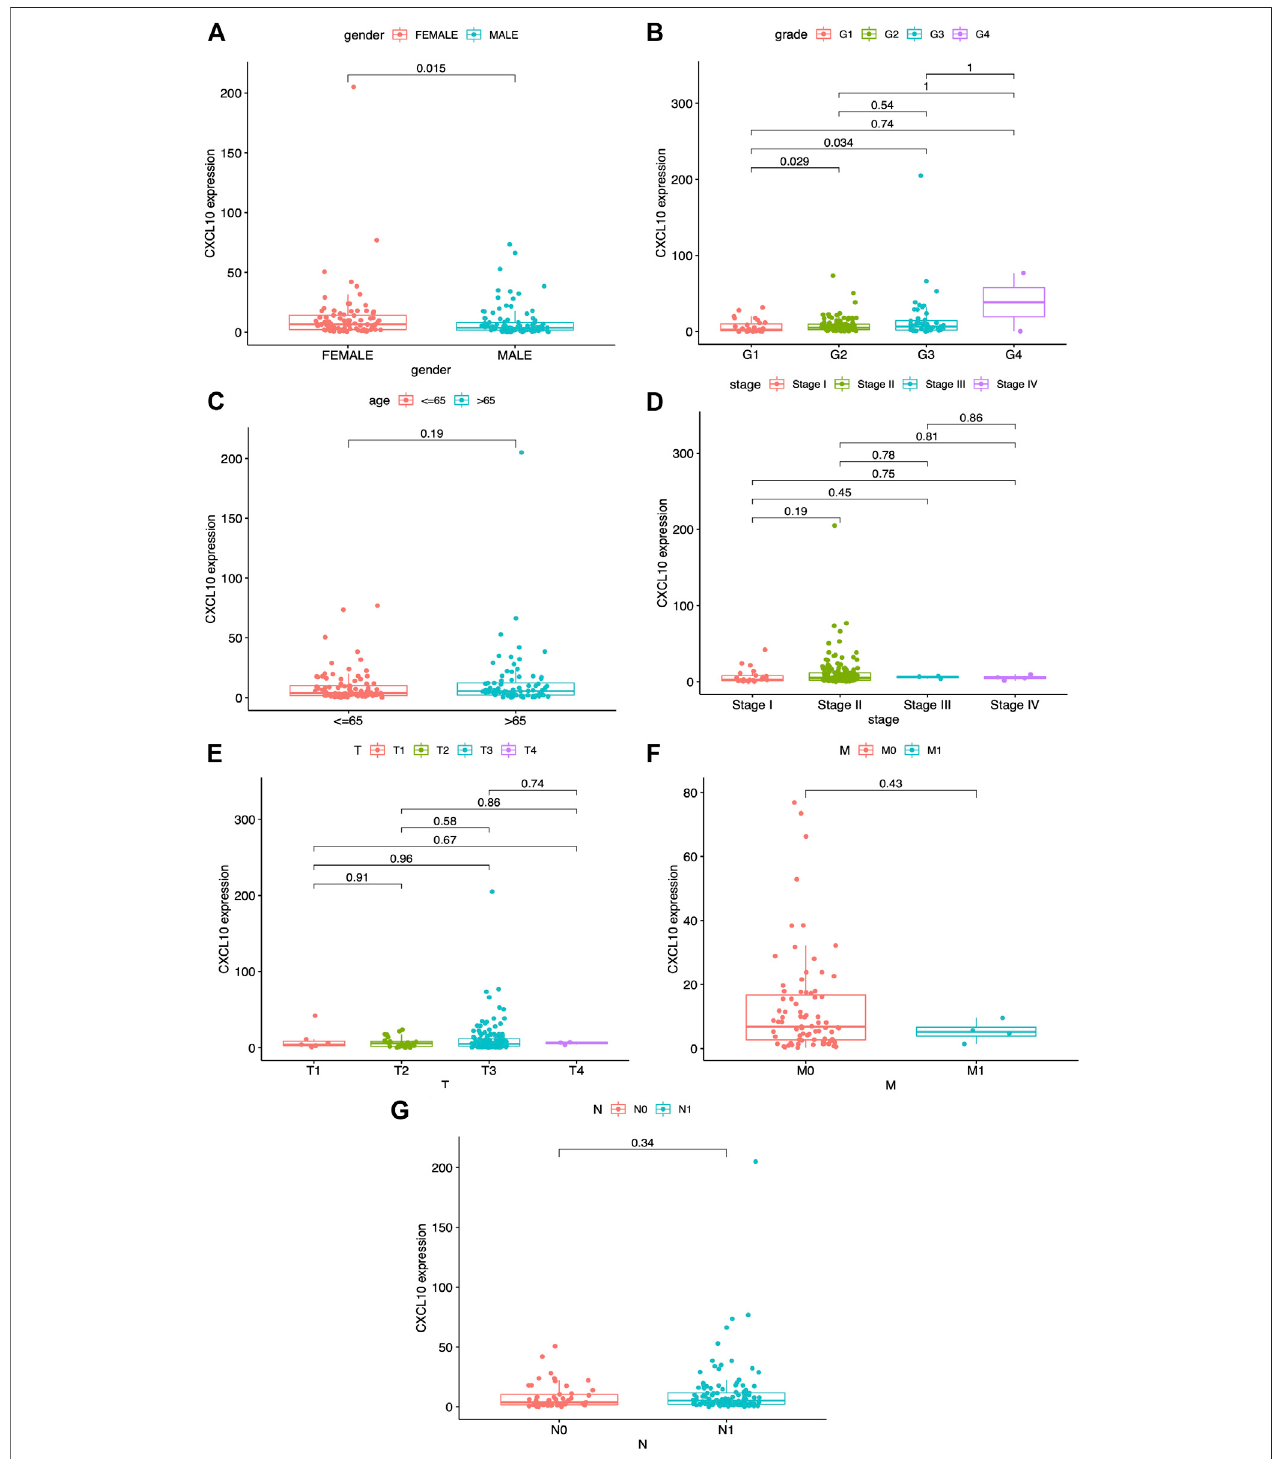
FIGURE7| CorrelationbetweenCXCL10expressionandclinico-pathologicalcharacteristics. (A) CorrelationofCXCL10expressionandgender. (B) Correlationof CXCL10 expression and grade. (C) Correlation of CXCL10 expression and age. (D) Correlation of CXCL10 expression and stage. (E-G) Correlation of CXCL10 expression and TNM staging. Statistical analysis were based on Kruskal-Wallis rank-sum test.